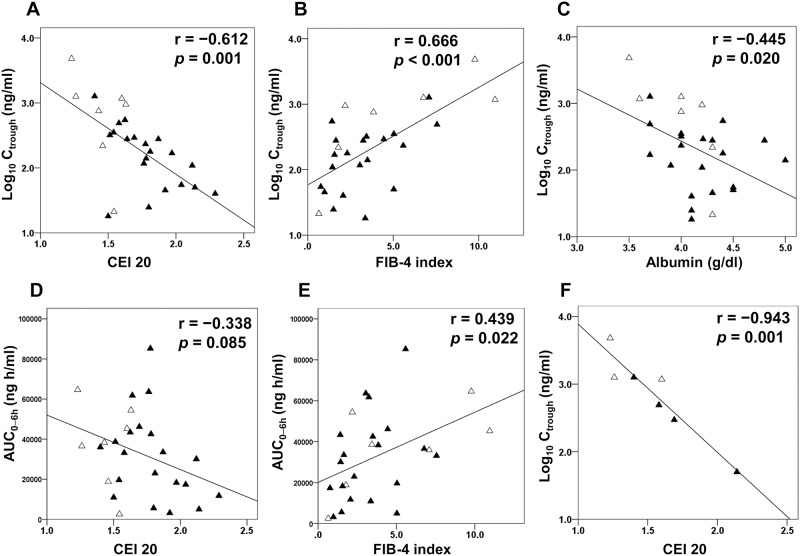
Relationship between pharmacokinetic parameters of paritaprevir and CEI 20 (A, D); FIB-4 index (B, E); and serum albumin concentration (C) in all patients and relationship between trough concentration of paritaprevir and CEI 20 in cirrhotic patients (F).Black triangle, patients without hyperbilirubinemia; open triangle, patients with hyperbilirubinemia. AUC0–6h, area under the blood concentration–time curve 0–6 h; CEI 20, contrast enhancement index at 20 min; Ctrough, trough concentration.